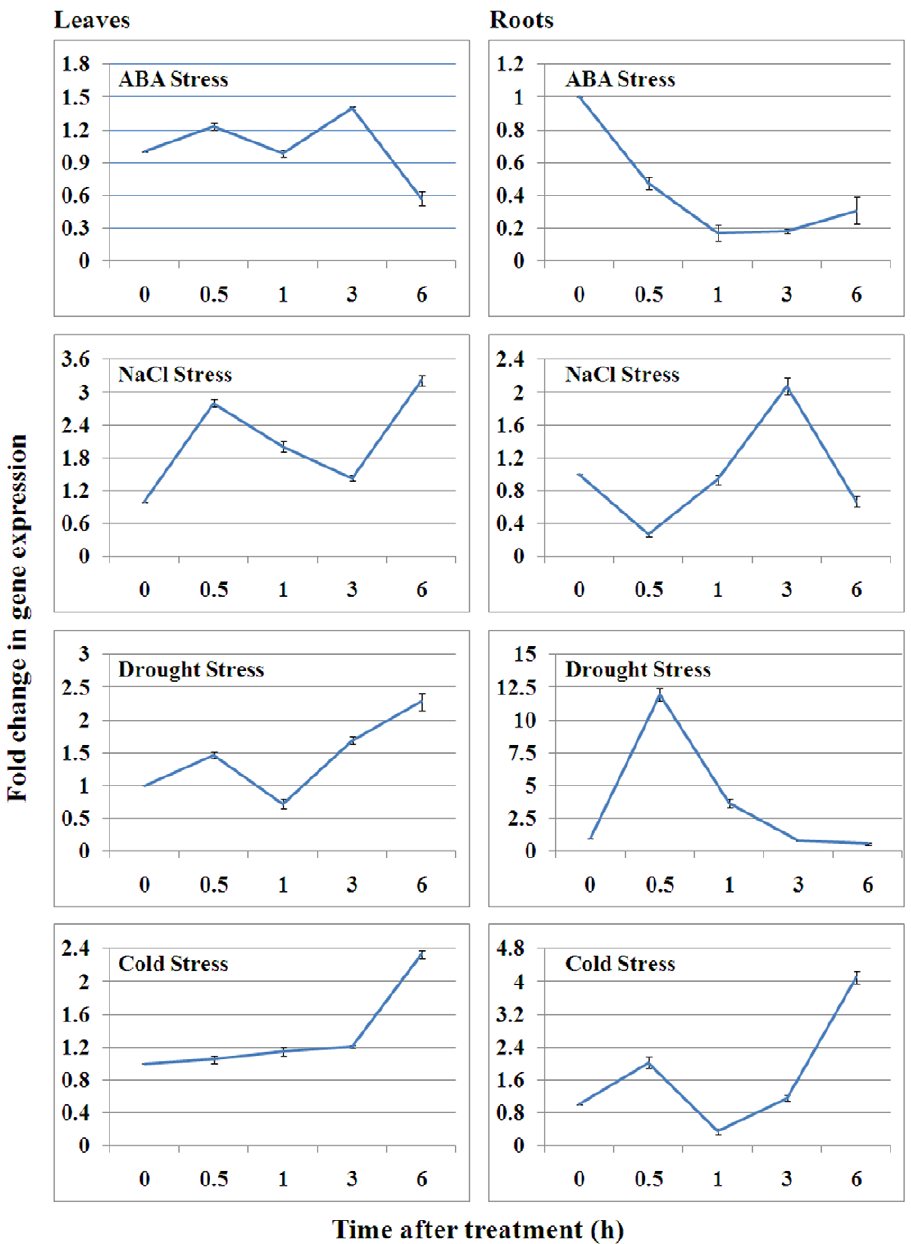
Figure 3. Expression pattern of GsAPK gene in Glycinesoja after exposure to various abiotic stresses. Total RNA was extracted from leaves or roots of one-month-old Glycine soja exposed to various stress treatments. Relative transcript levels were determined by real-time PCR according to the 2 2 DD C T method [57] using actin gene as an internal control. Gene expression was normalized to the unstressed expression level, which was assigned a value of 1. Data represent the average of three independent biological experiments 6 S.E. ABA treatment, 100 m M ABA; Salt treatment, 200 mM NaCl; Drought treatment, 30% (W/V) PEG 6000; Cold treatment, 4 u C.